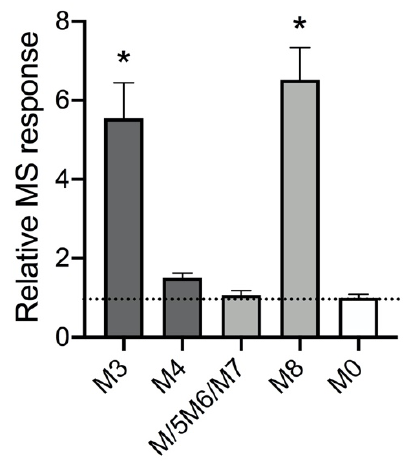
Figure 3. Relative MS responses for 5F-APINACA metabolites. We analyzed metabolites from a 200 μM 5F-APINACA reaction as described under Methods and then used values to assess relative